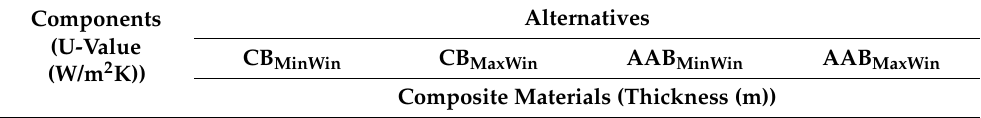
Table 2. Building components with composite materials of studied